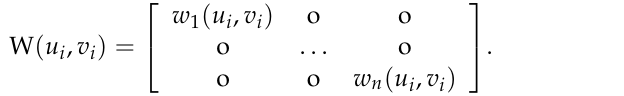
Figure S2: Raw values of transformed environmental